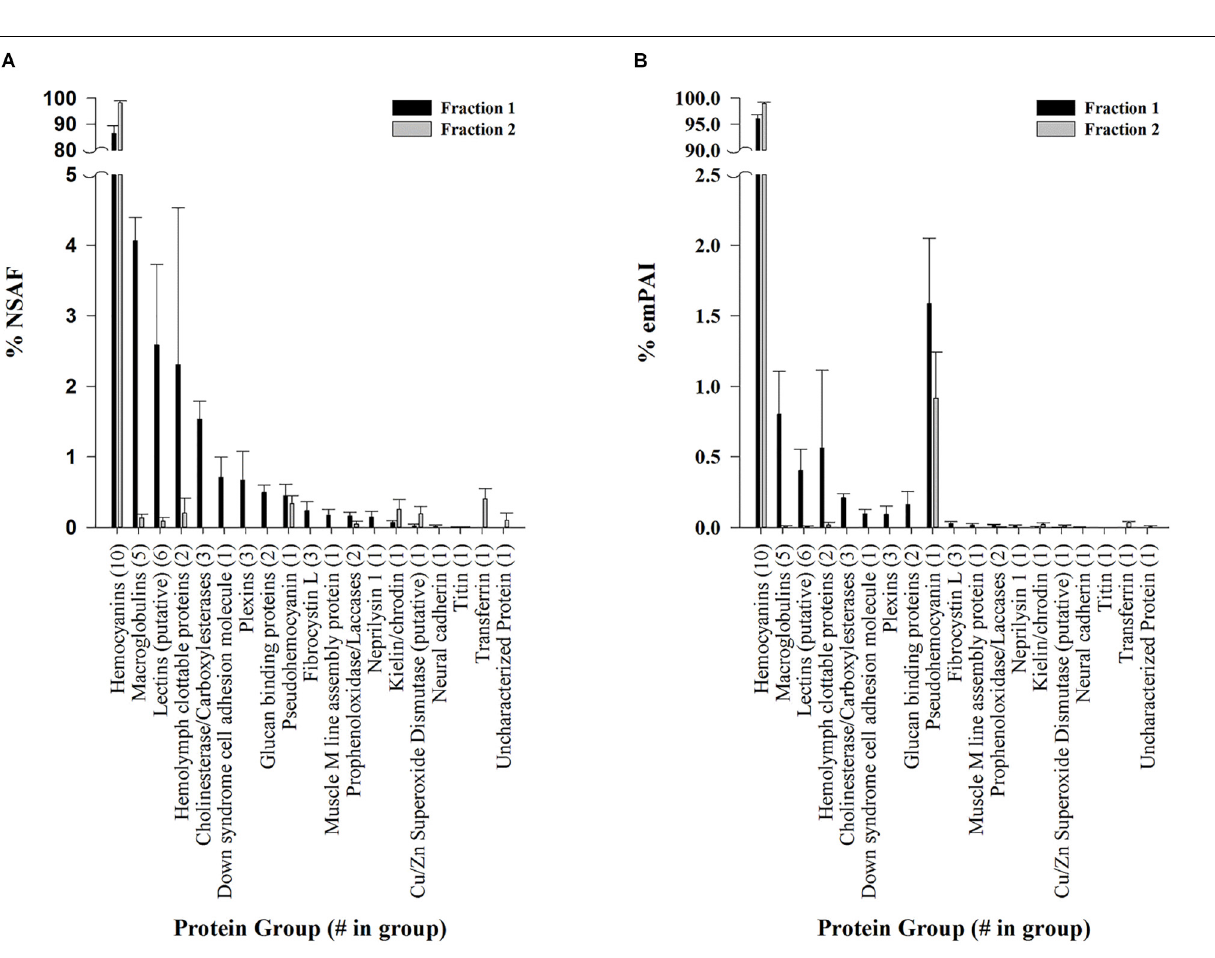
FIGURE 3 | Protein groups identified in L. vannamei hemolymph fractions by LC-MS/MS. Semi-quantitative values are listed as molar fractions (average ± SEM; n = 5) calculated from (A) NSAF and (B) emPAI values summed over all identified proteins. The number of putative protein hits from the reference genome assembly ASM378908v1 (Zhang et al., 2019) or contig hits from the translated L. vannamei transcriptome database (Johnson et al., 2015) are listed in parenthesis for each group. All peptides and proteins were identified at < 1% protein FDR with 2 minimum peptides at < 1% local peptide FDR. Fraction 1 (black bars) and 2 (gray bars) represent dodecamer and hexamer fractions